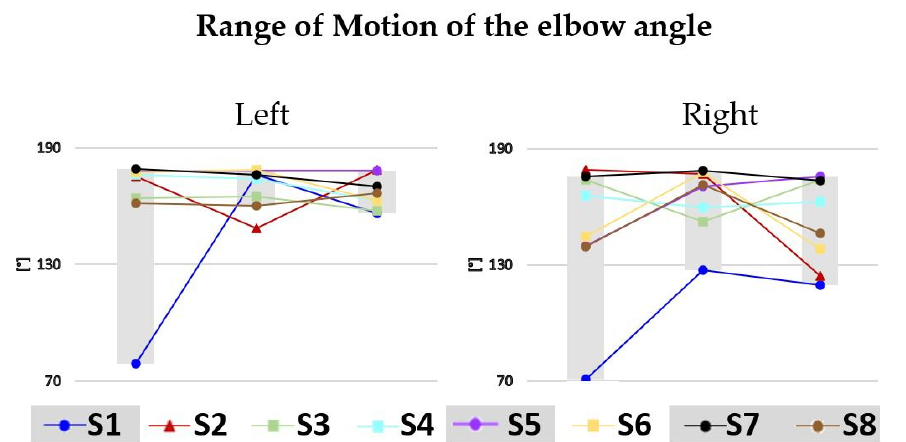
Figure 6. Range of motion of the elbow angle for the left and right side for each infant at each time point (3, 4, and 5 months). Infants not suggesting atypical development to both physicians are identified with circles, infants raising the concern of both physicians are identified with triangles, and infants differently evaluated by the physicians are identified by squares. Infants not suggesting atypical development define the gray interval at each time point. at each timepoint (3, 4, and 5 months) together with the number of bouts and